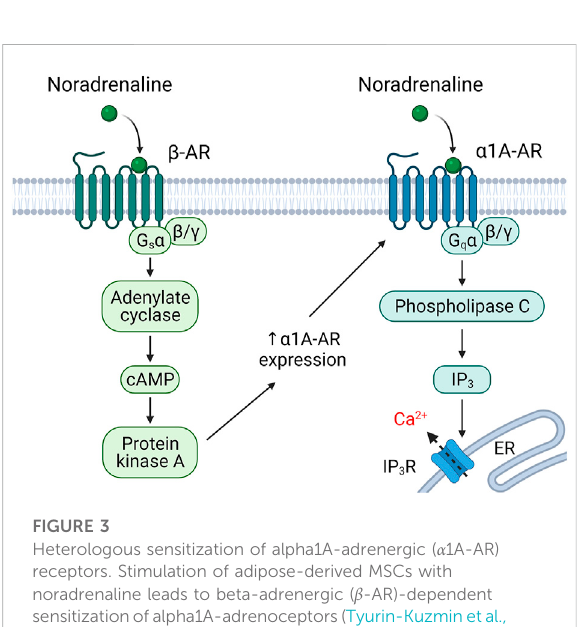
FIGURE 3 Heterologous sensitization of alpha1A-adrenergic ( α 1A-AR) receptors. Stimulation of adipose-derived MSCs with noradrenaline leads to beta-adrenergic ( β -AR)-dependent sensitizationofalpha1A-adrenoceptors(Tyurin-Kuzminetal.,